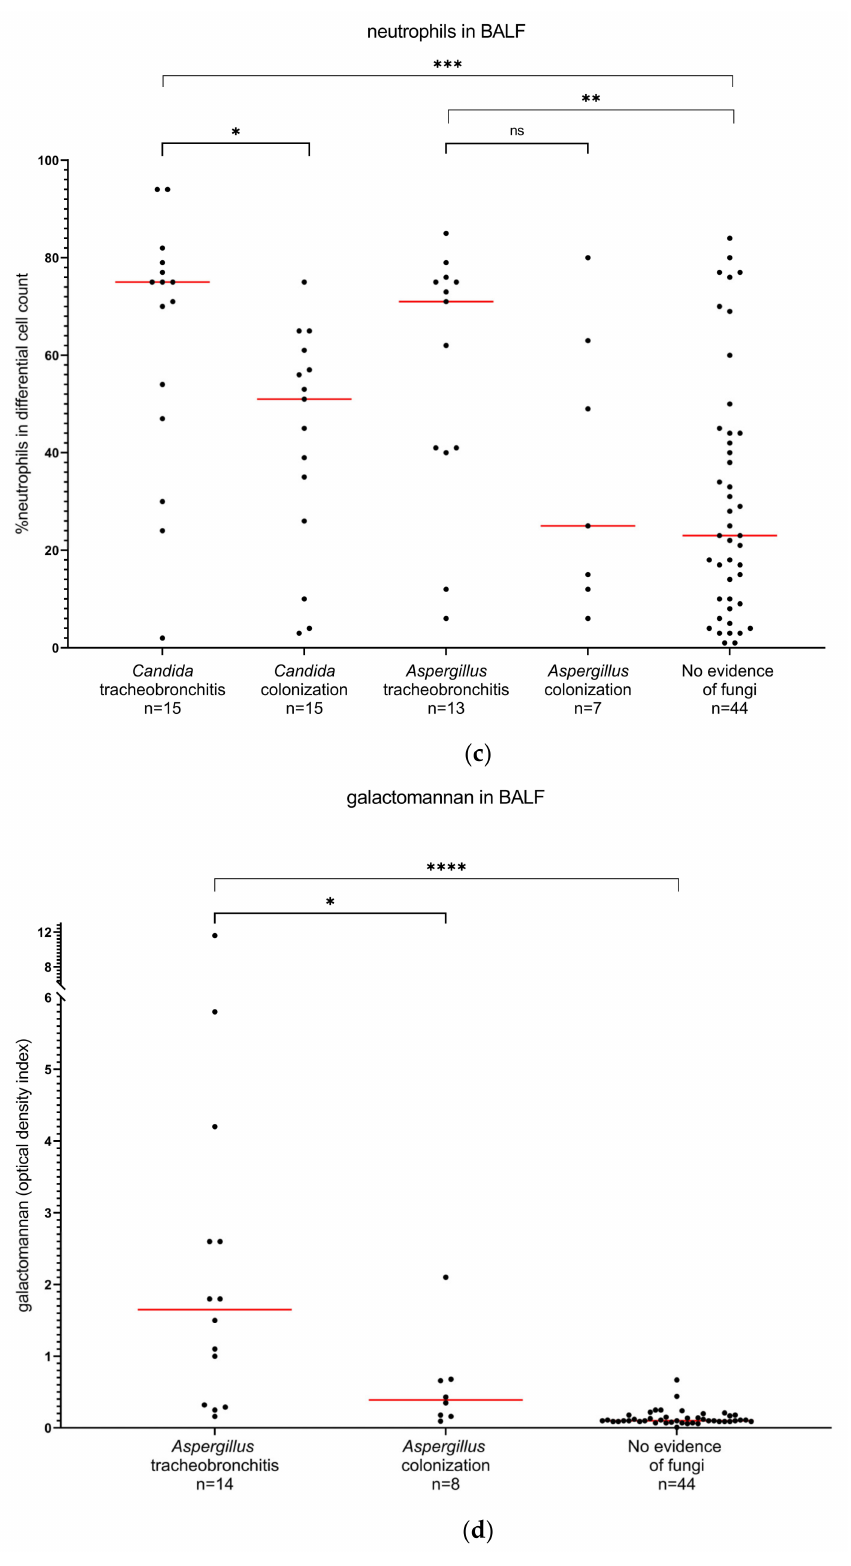
Figure 3. Betaglucan in serum ( a ), betaglucan in BALF ( b ), neutrophils in BALF ( c ) and galactomannan in BALF ( d ) in patients with fungal tracheobronchitis, fungal colonization and no evidence of fungi during the first year after lung transplantation. A p -value of <0.05 was considered statistically significant (* p <0.05, ** p <0.01, *** p < 0.001 and **** p < 0.0001). The red line corresponds to the median